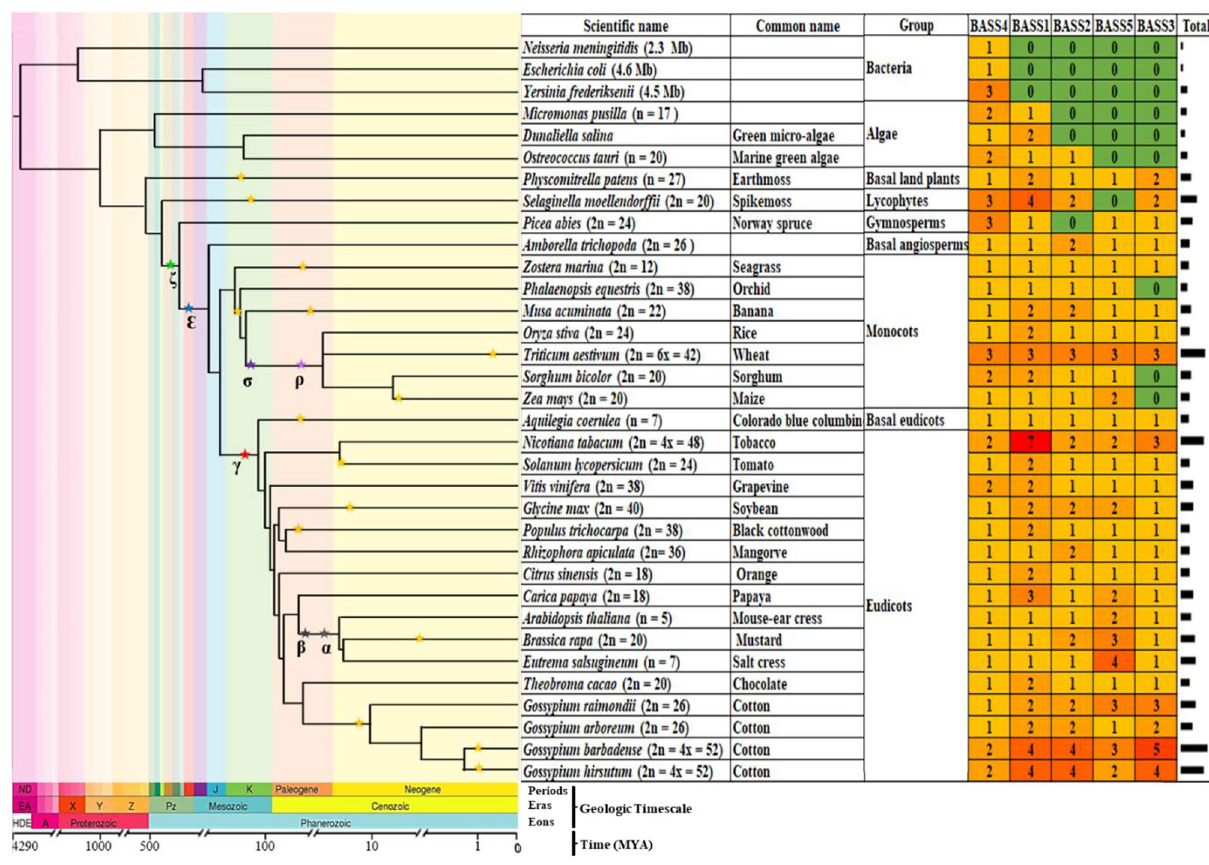
Figure 1. Species phylogeny and the number of BASS genes in each species. The species tree was inferred from Zeng et al. 21 . The divergence time was estimated by molecular clock dating from TimeTree 22 . Stars on the branches represent WGD events. ζ , ancestral seed plant WGD; ε, ancestral angiosperms WGD; γ, triplication event; β and α, two recent WGD events in Eudicots; σ and ρ, two polyploidy events in monocots. The scientific name, common name and group are followed by the number of BASSs identified. MYA, million years